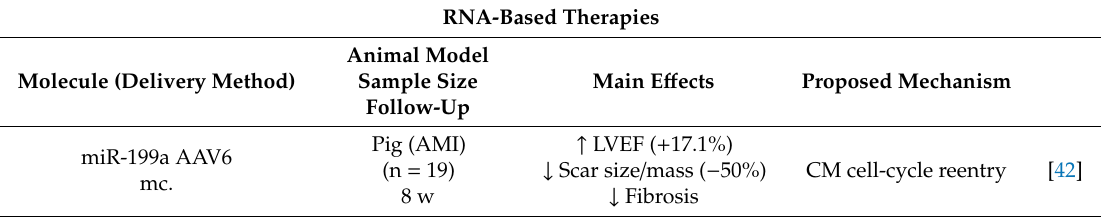
Table 2. RNA-based therapies in large animal models of cell-free cardiac